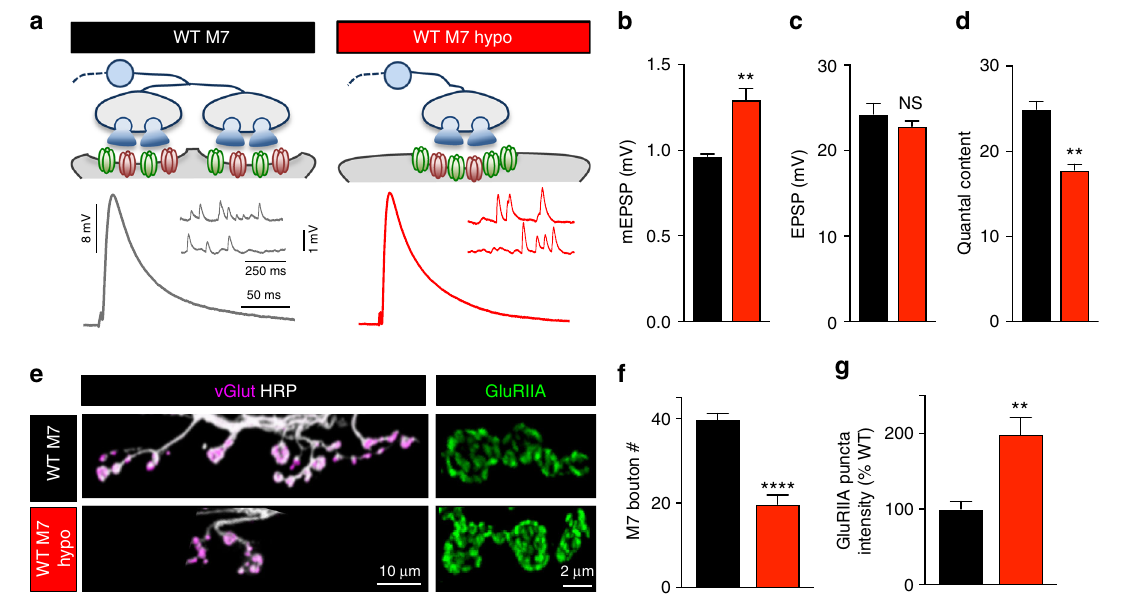
Fig. 8 Hypo-innervation induces a homeostatic increase in postsynaptic GluR abundance. a Schematic illustrating a wild type and hypo-innervated muscle 7 synapse at the Drosophila NMJ achieved by overexpression of FasII selectively on the adjacent muscle 6 (WT M7 hypo: w ; tubP>stop>Gal4,UAS-FLP,UAS- CD8-GFP/UAS-FasII-PEST + ; H94-Gal4,nSyb-Gal80 ). A compensatory increase in mEPSP amplitude is observed that maintains baseline levels of synaptic strength (EPSP amplitude). Representative mEPSP and EPSP traces of the indicated genotypes recorded are shown below. Quanti fi cation of mEPSP amplitude ( b ), EPSP amplitude ( c ), and quantal content ( d ) in the indicated genotypes. e Representative images of muscle 7 larval NMJs in wild type (WT) and WT M7 hypo immunostained with antibodies that recognize vGlut and the neuronal membrane (HRP). Note the reduced innervation of boutons onto muscle 7 in the WT M7 hypo condition. Right: Representative GluRIIA staining of the corresponding genotypes. An upregulation in GluRIIA levels is observed on the hypo-innervated muscle 7. Quanti fi cation of bouton numbers ( f ) and GluRIIA puncta intensity ( g ) of the indicated genotypes. Error bars indicate± SEM. For statistical signi fi cance, an unpaired t -test was performed. ** p 0.01; **** p 0.0001; NS not signi fi cant, p >